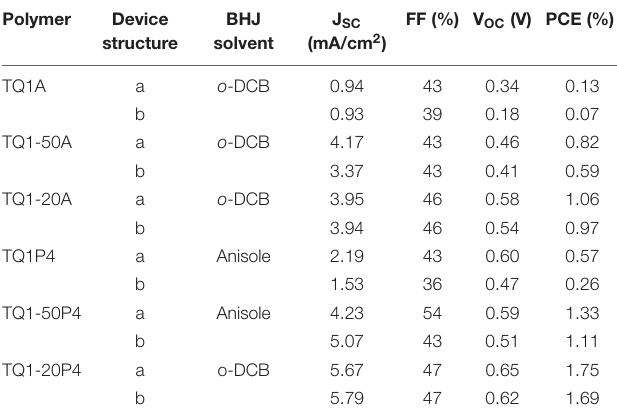
TABLE 1 | Photovoltaic performance of the best BHJ OPVs based on TQ1A, TQ1-50A, TQ1-20A, TQ1P4, TQ1-50P4, and TQ1-20P4 with PC 61 BM (fixed Donor:Acceptor 1:2.5 weight ratio) blends with device structure of a ITO/ZnO/BHJ/TPD/MoO 3 /Ag and b ITO/ZnO/BHJ/MoO 3 /Ag. Polymer Device